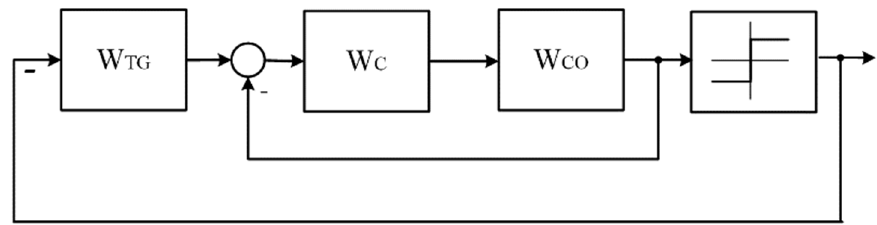
Figure 8. Block diagram of the substitution of VSS.